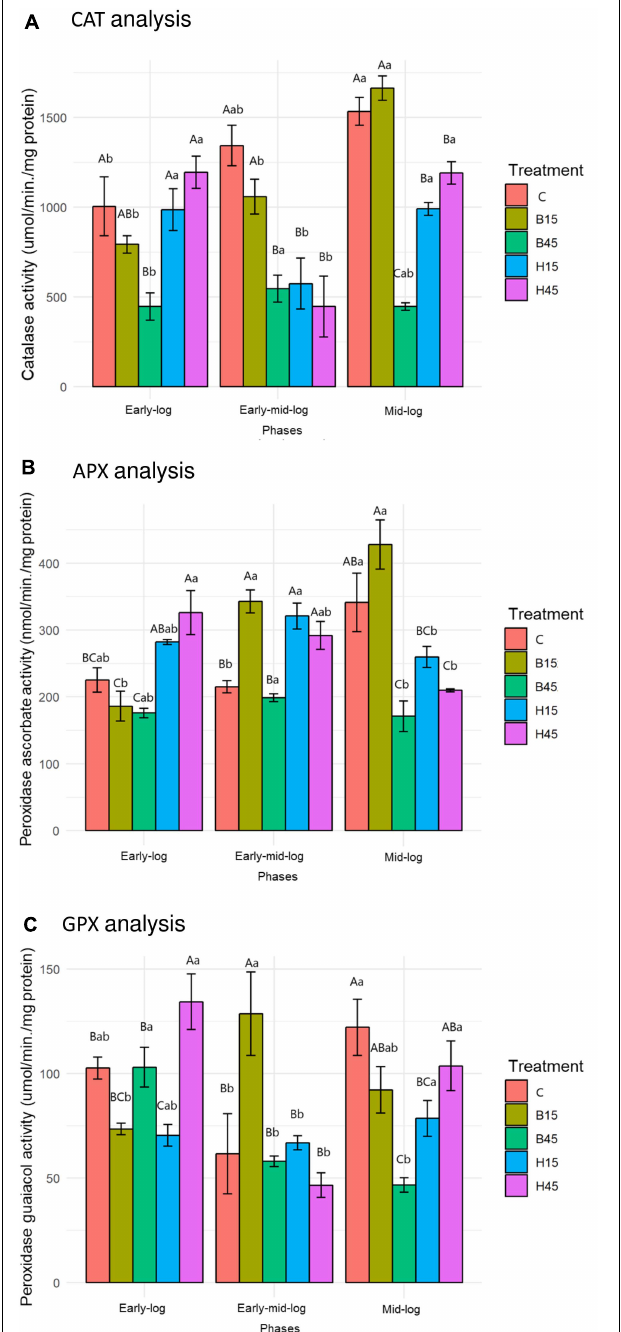
FIGURE 7 | CAT (A) , APX (B) , and GPX (C) activity of Pseudomonas sp. CMA 6.9 in control treatments (C) and with the herbicides Boral R (cid:13) (B15 and B45) and Heat R (cid:13) (H15 and H45) in the three growth phases indicated. Data were obtained in triplicate for each treatment and statistically analyzed using a randomized complete block design using the Duncan test ( p < 0.05). Error bars represent standard errors of the means. Different uppercase letters represent statistically significant differences between treatments at the same time; lower-case letters represent statistically significant differences between treatments at different times. CAT, catalase; APX, ascorbate peroxidase; GPX, guaiacol